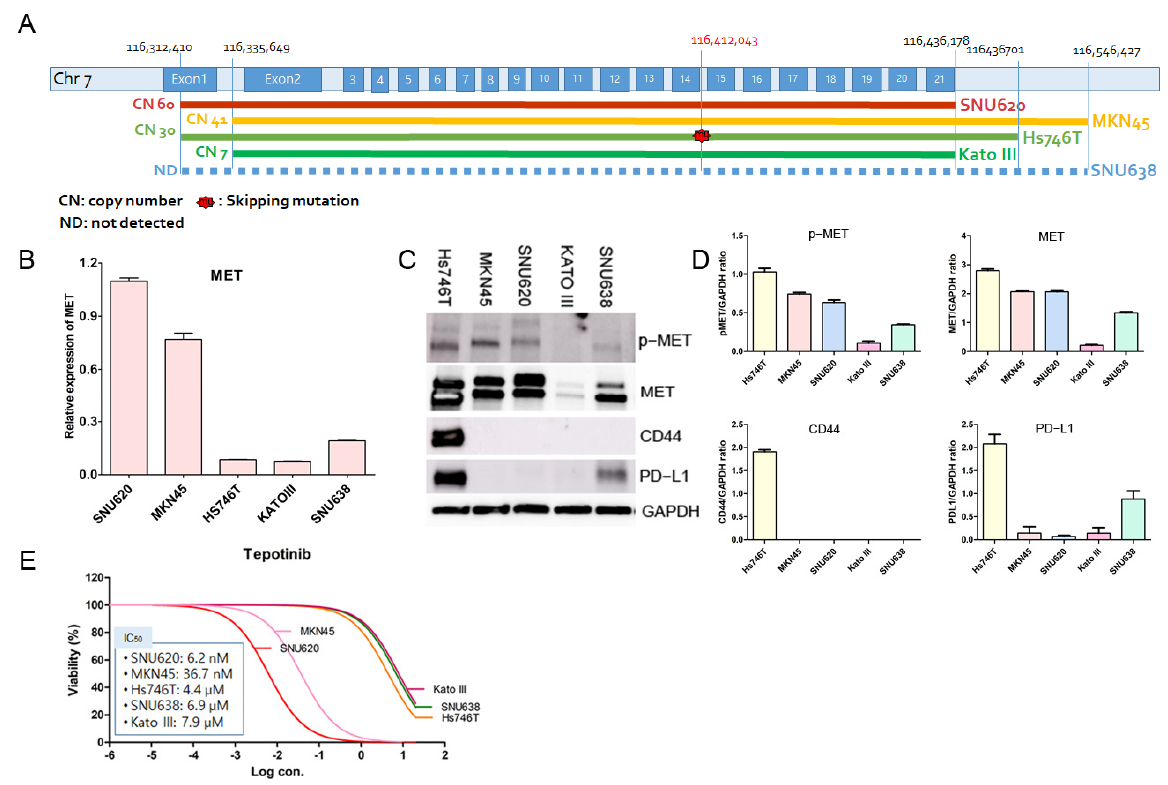
Figure 2. Effects of tepotinib on cell viability in GC cell lines with or without MET gene overexpression and p-MET, MET, CD44, and PD-L1 protein expression. ( A ) Human GC cell lines, MET gene structures, and copy numbers (CNs) are measured by targeted NGS. ( B ) MET mRNA expression levels were determined by qRT-PCR. ( C ) Protein expression levels of p-MET, MET, CD44, and PD-L1 were determined using Western blot analysis. ( D ) Using the image J for densitometry analysis. ( E ) Five GC cell lines were treated with various concentrations of tepotinib for 48 h.